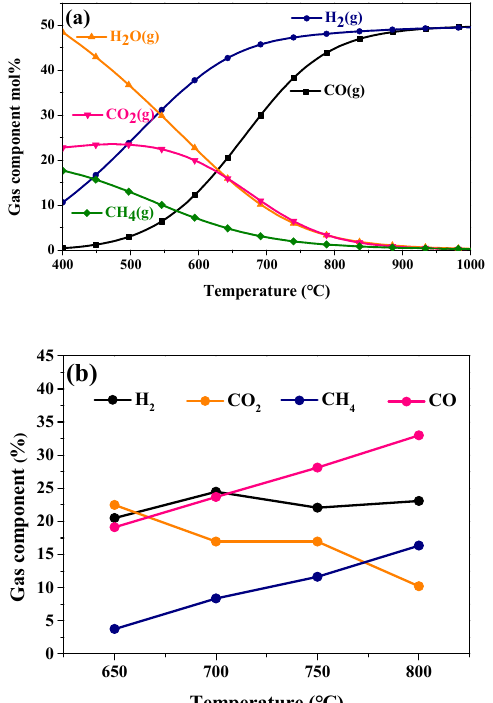
Figure 4. ( a ) the thermodynamic calculation of 50% CO 2 -50% C 2 H 5 OH dry reforming reactions; ( b ) gas composition of single cell with N-LSCFC reforming catalyst from 800 °C to 650 °C in 50% CO 2 -50% C 2 H 5 OH atmosphere.